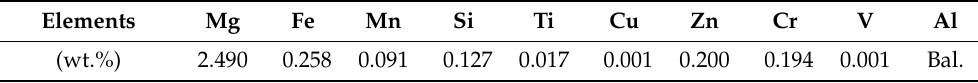
Table 1. Chemistry composition of the AA5052-H32 alloy material.